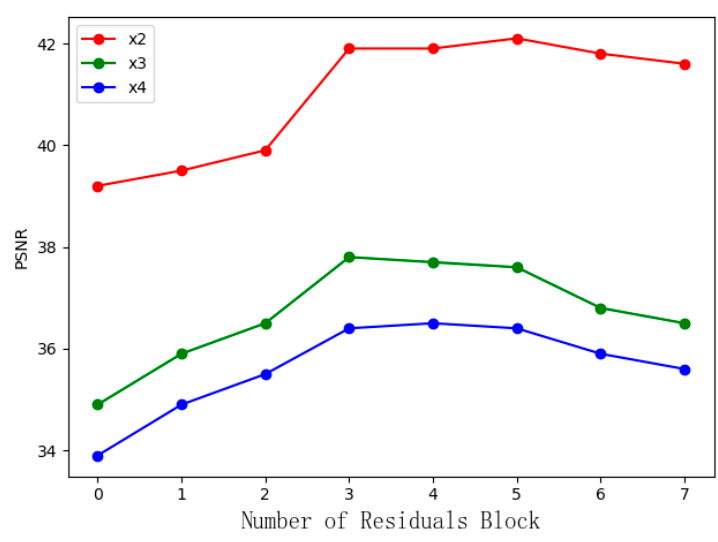
Figure 8. Influence of SCRB module number on PSNR.